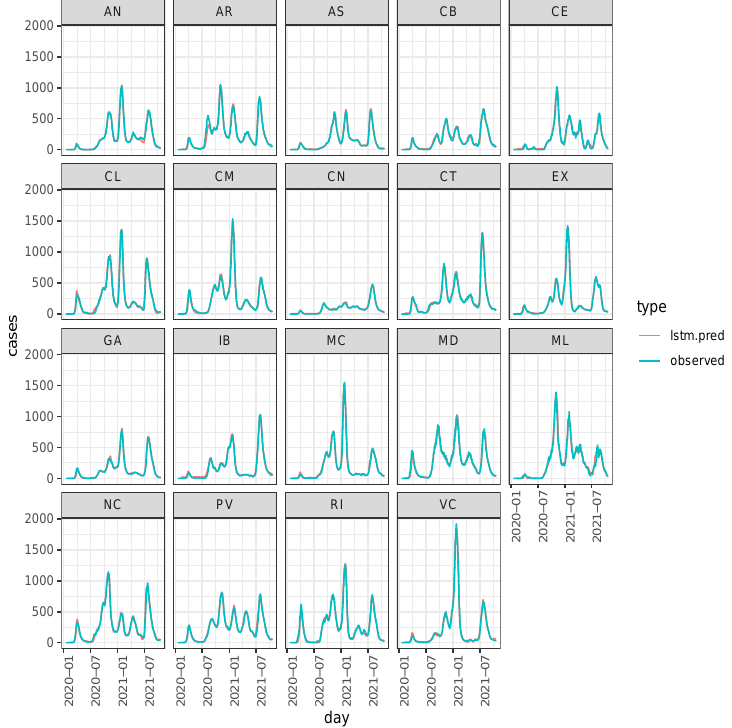
Figure A2. Predicted (cid:98) y ts and observed daily incidence over the whole observed